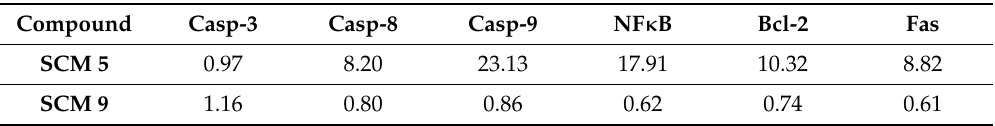
Table 7. E ff ect of SCM compounds on expression of selected signaling molecules in WEHI 231 cells. For description see Table 5